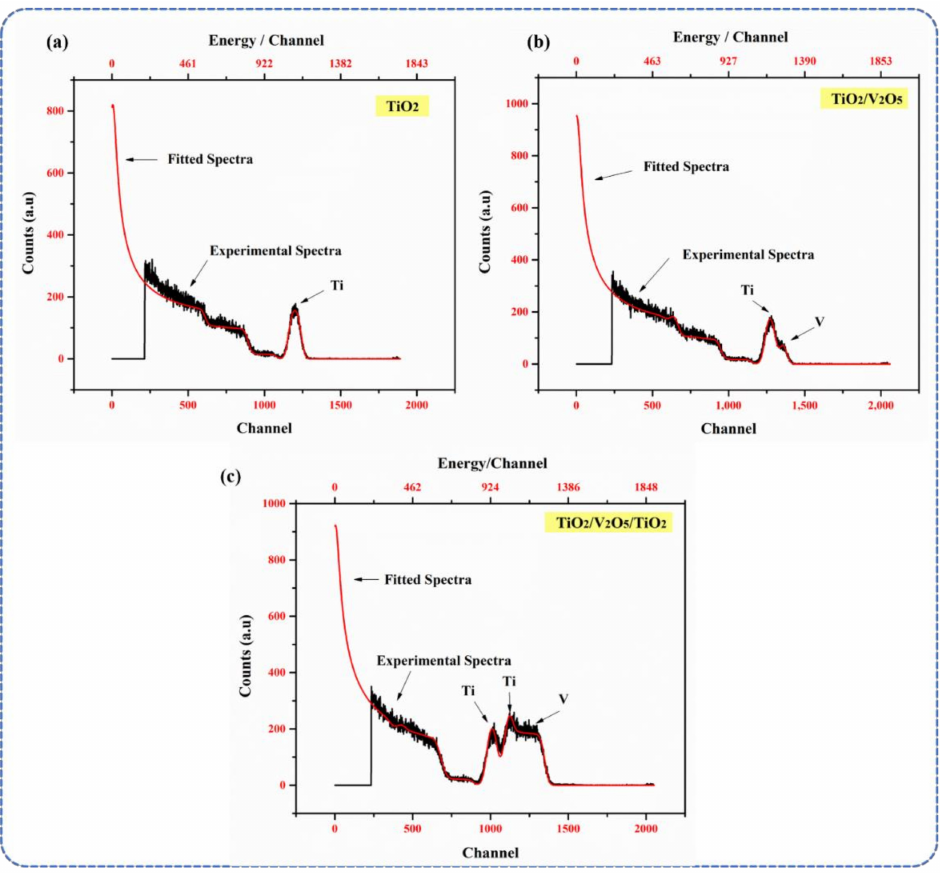
Figure 2. RBS spectra of ( a ) mono-layer TiO 2, ( b ) bi-layer TiO 2 /V 2 O 5 , and ( c ) multi-layer TiO 2 /V 2 O 5 thin films,